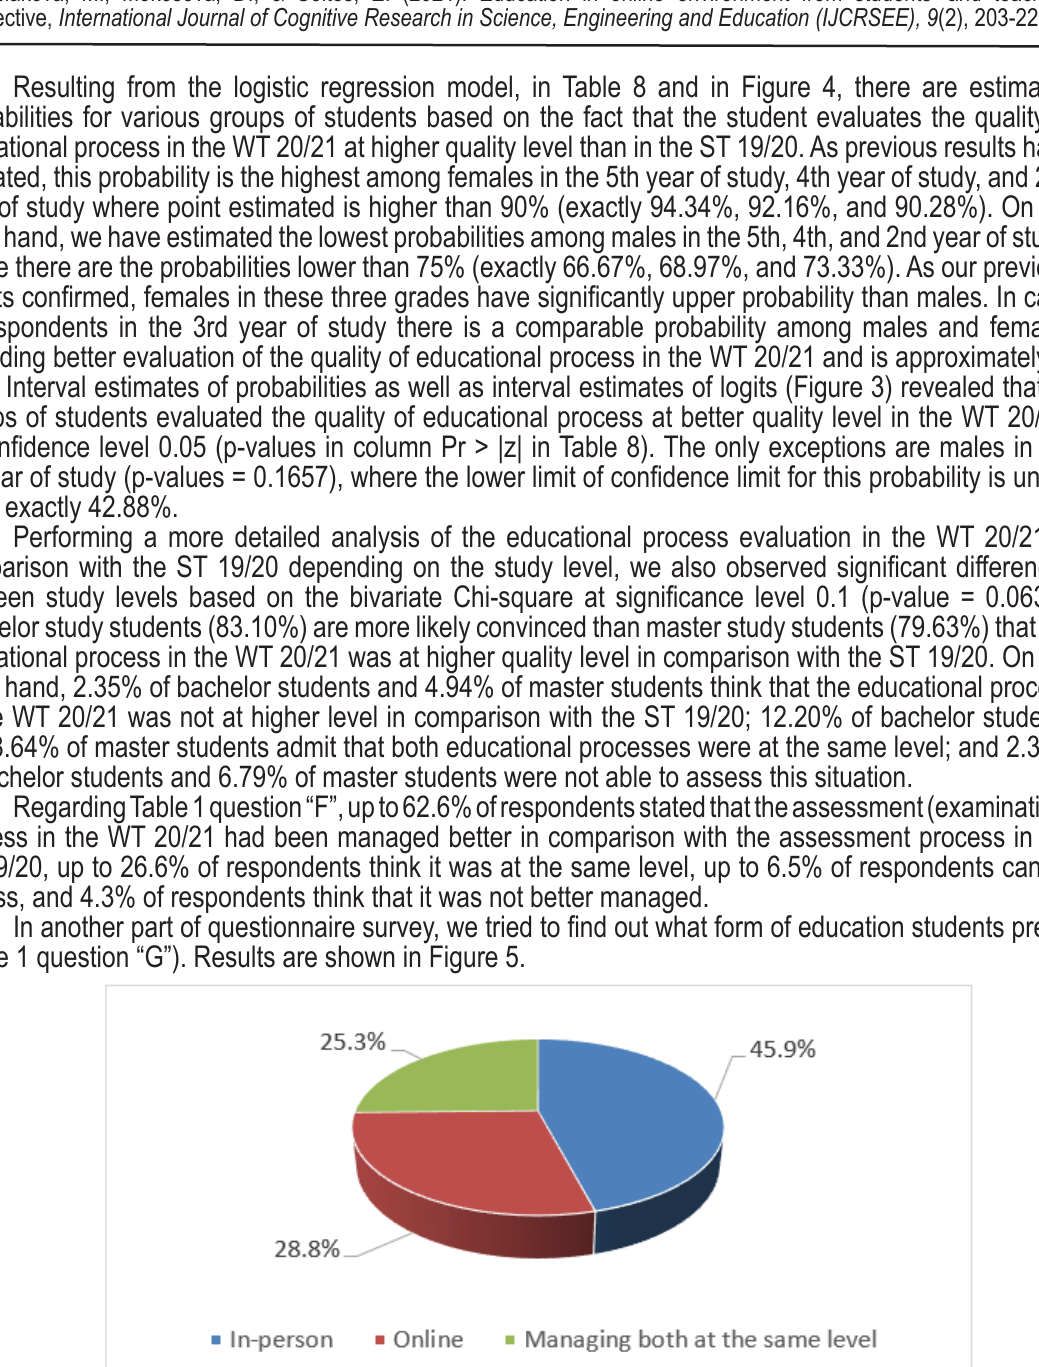
Figure 5. Preferred form of education by students Source: Own questionnaire